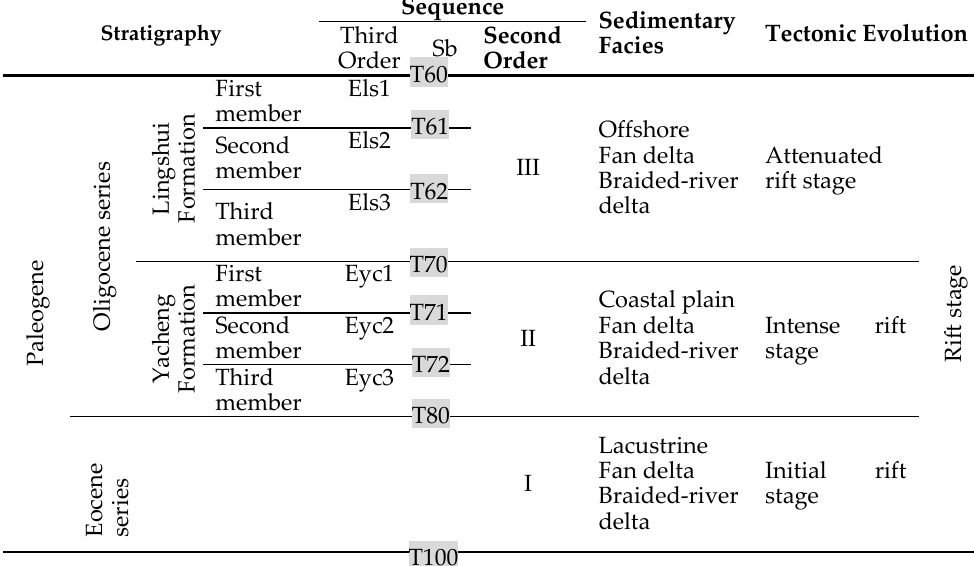
Figure 1. The location and structural divisions of the QDN Basin. Points b , d , and e , and black dashed lines A, B, C, D, and E are the research locations used in the following figures. Table 1. The Paleogene stratigraphy and sedimentary environment of the QDN Basin.